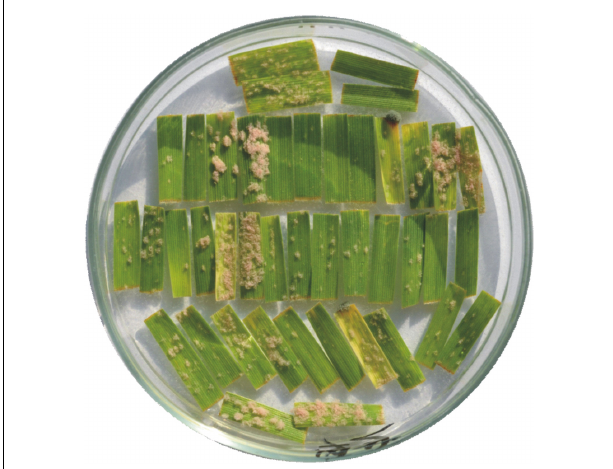
( Table 1 ) for 30 s, and 72 ◦ C for 30 s. The PCR reactions were completed with an elongation step of 72 ◦ C/10